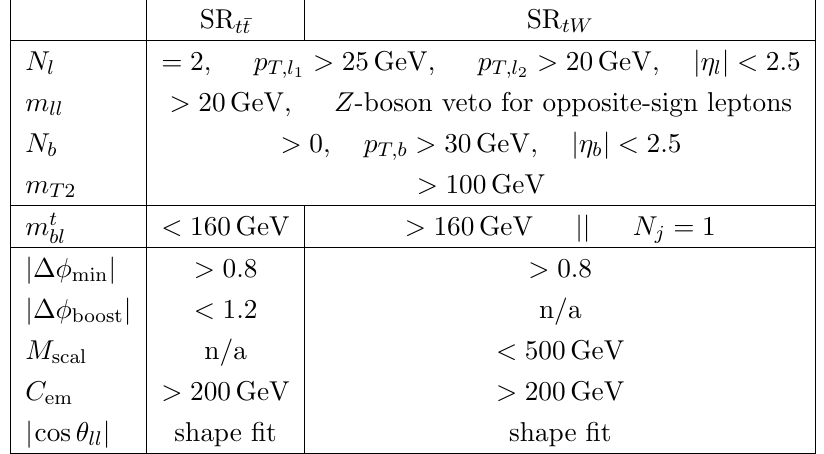
Table 1 . De(cid:12)nition of the two signal regions SR where l and l denote the two (cid:12)nal-state leptons and the minimisation runs over all pairs 1 2 f j ; j g of jets inside a prede(cid:12)ned set of test jets. Based on the number of b -jets in a b